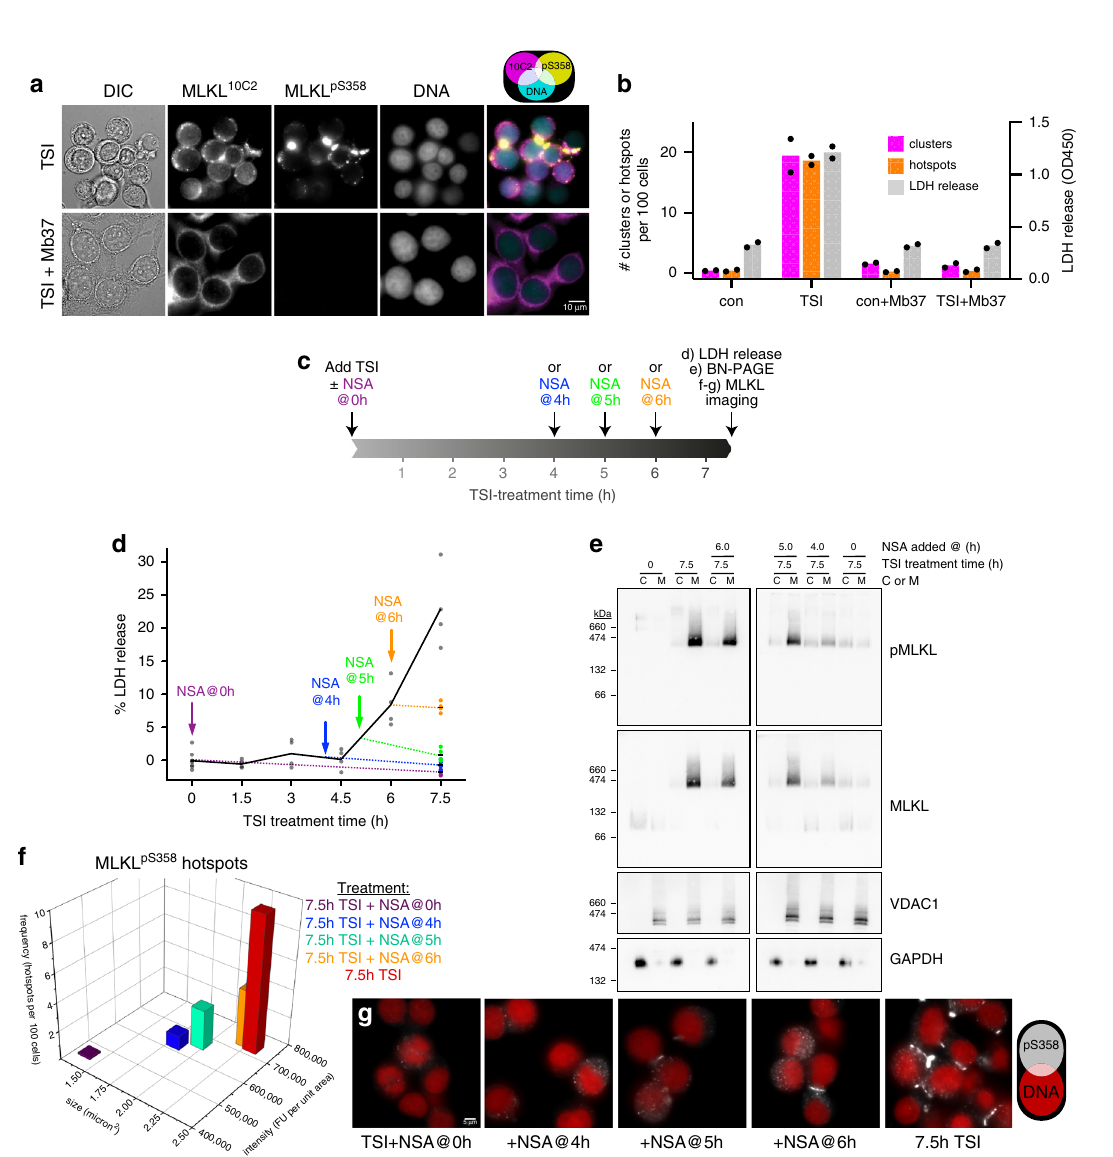
Fig. 3 Necroptosis relies on exceeding a threshold level of plasma membrane pMLKL. a Images of TSI-treated HT29 cells expressing Mb37 stained for MLKL 10C2 , MLKL pS358 and DNA (Hoechst). b Mean frequency of clusters and hotspots from n = 2 independent experiments ( N > 1500 cells per group) with raw lactate dehydrogenase (LDH) release values taken from the same samples. c – g Necrosulfonamide (NSA) was added to HT29 cells together with TNF, Smac mimetic and IDN-6556 (TSI) or 4 – 6 h after TSI addition. Plasma membrane lysis (LDH release; line shows mean of 4 biological replicates indicated as dots; data representative of n = 3 independent experiments) ( d ), MLKL activation ( e ) and hotspots ( f, g ) were measured after 7.5 h of TSI- treatment. e Cytosol (C) and membrane (M) fractions resolved by Blue Native-PAGE and immunoblotted for MLKL and MLKL pS358 . Uncropped blots are included as Source Data. Fractionation was veri fi ed by probing for voltage-dependent anion channel 1 (VDAC1; membrane), glyceraldehyde-3- phosphosphate dehydrogenase GAPDH (cytosol); representative of n = 2 independent experiments. f Mean frequency, intensity and size of hotspots from one experiment ( N = 1309-1740 cells per group); representative of n = 3 independent